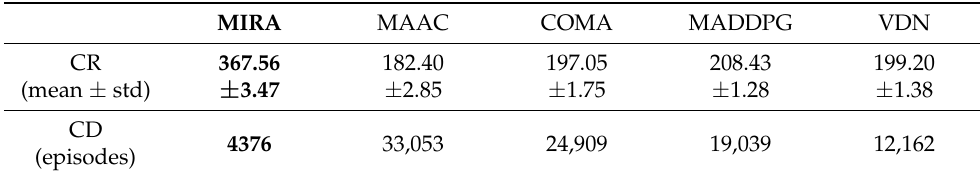
Table 2. Convergence performance of evaluated algorithms on